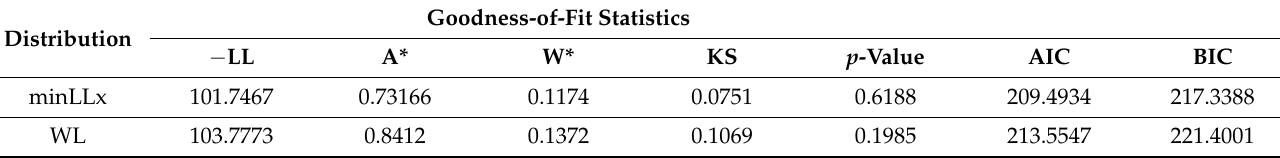
Table 7. Some goodness of fit statistics for the fitted models to the first data set.